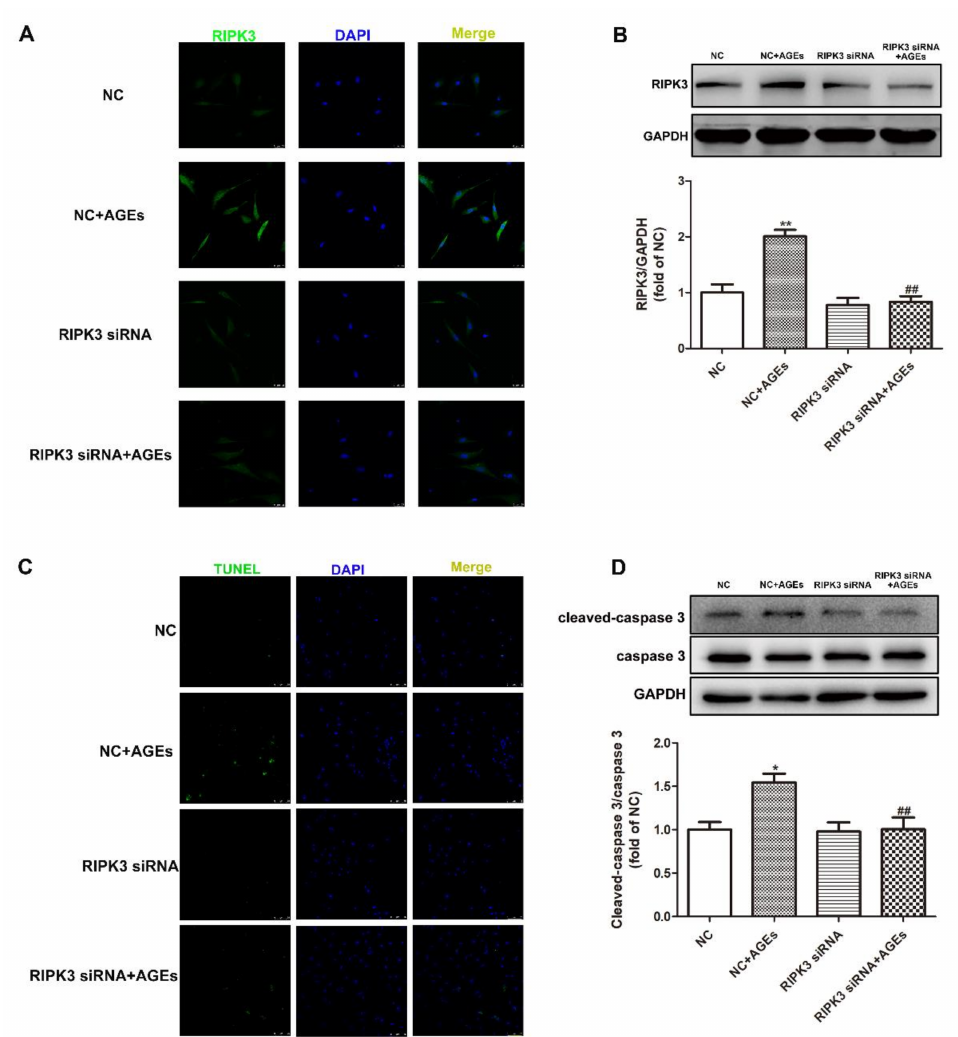
Figure 7. Down regulation of RIPK3 inhibited necroptosis in cardiomyocytes. Cardiomyocytes were transfected with RIPK3 siRNA for 4 h followed by 200 µ g/mL AGEs stimulation for 24 h. ( A ) RIPK3 was immunofluorescence stained by Alexa Fluor 488 (Green)-conjugated IgG. The nuclei were stained by DAPI (Blue). Bar = 25 µ m. ( B ) The expression of RIPK3was detected by Western blot in cardiomyocytes. GAPDH was used as a loading control. ( C ) The apoptosis of cardiomyocytes was detected by One Step TUNEL Apoptosis Assay Kit. Bar = 75 µ m. ( D ) The expression of caspase 3 and Cleaved-caspase 3 was detected by Western blot in cardiomyocytes. GAPDH was used as a loading control. Plots represent the mean ± SEM; n = 6. Statistical significance: * p < 0.05, ** p < 0.01 compared with NC; ## p < 0.01 compared with